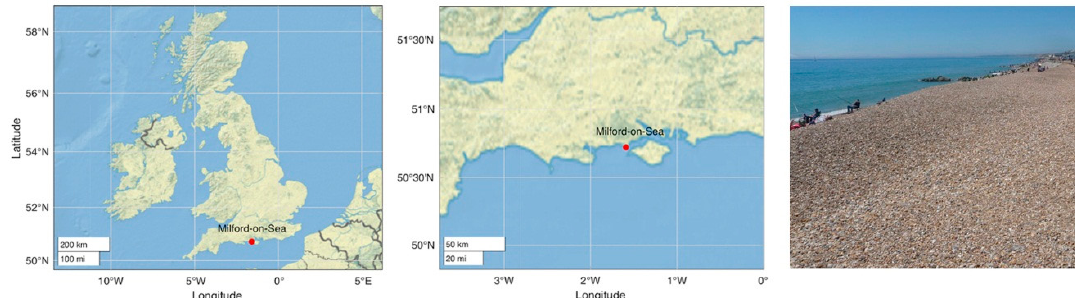
Figure 8. Study area location.